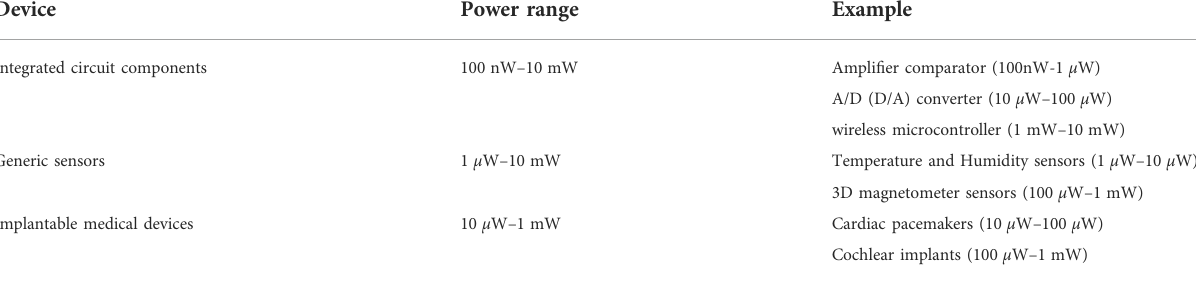
TABLE 2 Power consumption of low-power devices (Proto et al., 2017; Liu et al., 2022).